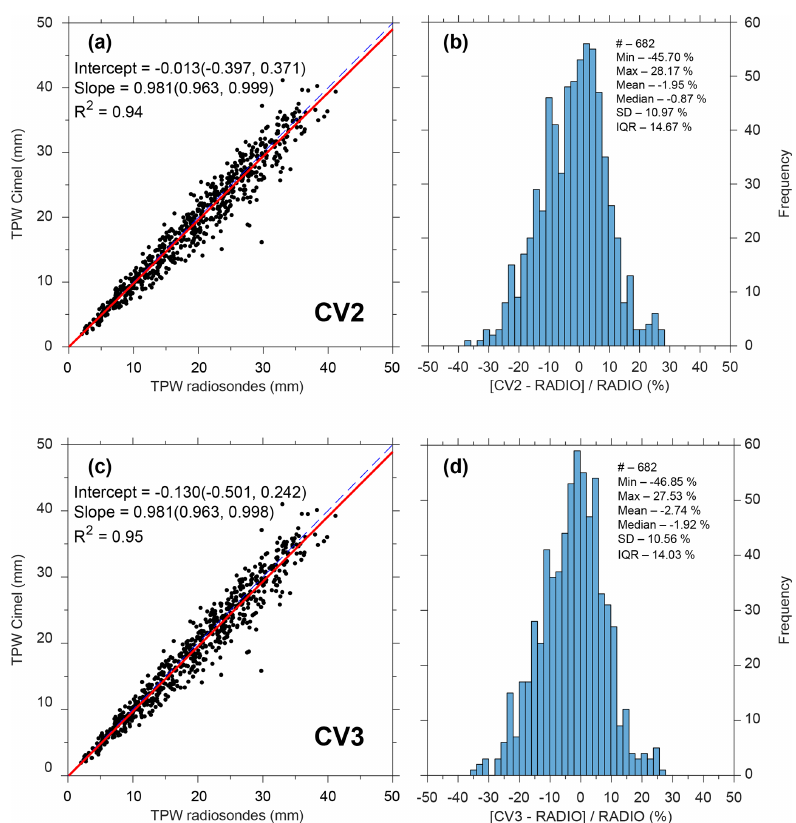
Figure 12. Scatter plot between the TPW from (a) the radiosondes and Cimel V2 and (c) Cimel V3. The red thick line shows the least-square regression line and the blue dashed line is the identity line. The regression coefficients are displayed along with their 95% confidence interval (in parentheses). Frequency histogram of the relative difference between (b) the TPW from the radiosondes and Cimel V2 and (d) Cimel V3.